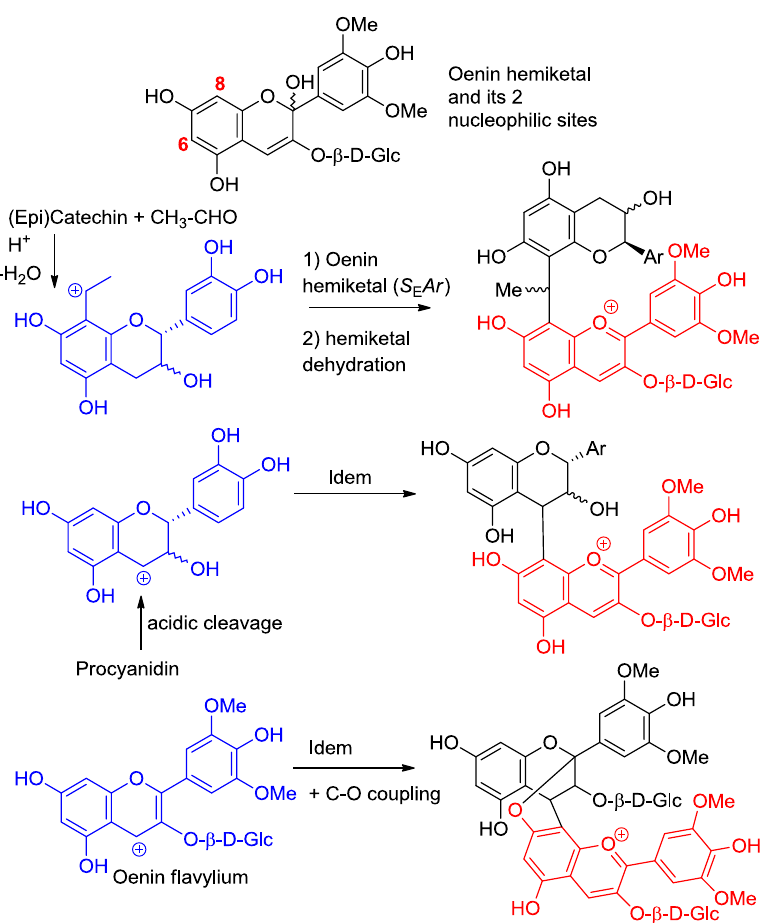
Figure 7. Anthocyanin hemiketals are nucleophiles reacting with carbocations (Ar = catechol ring).